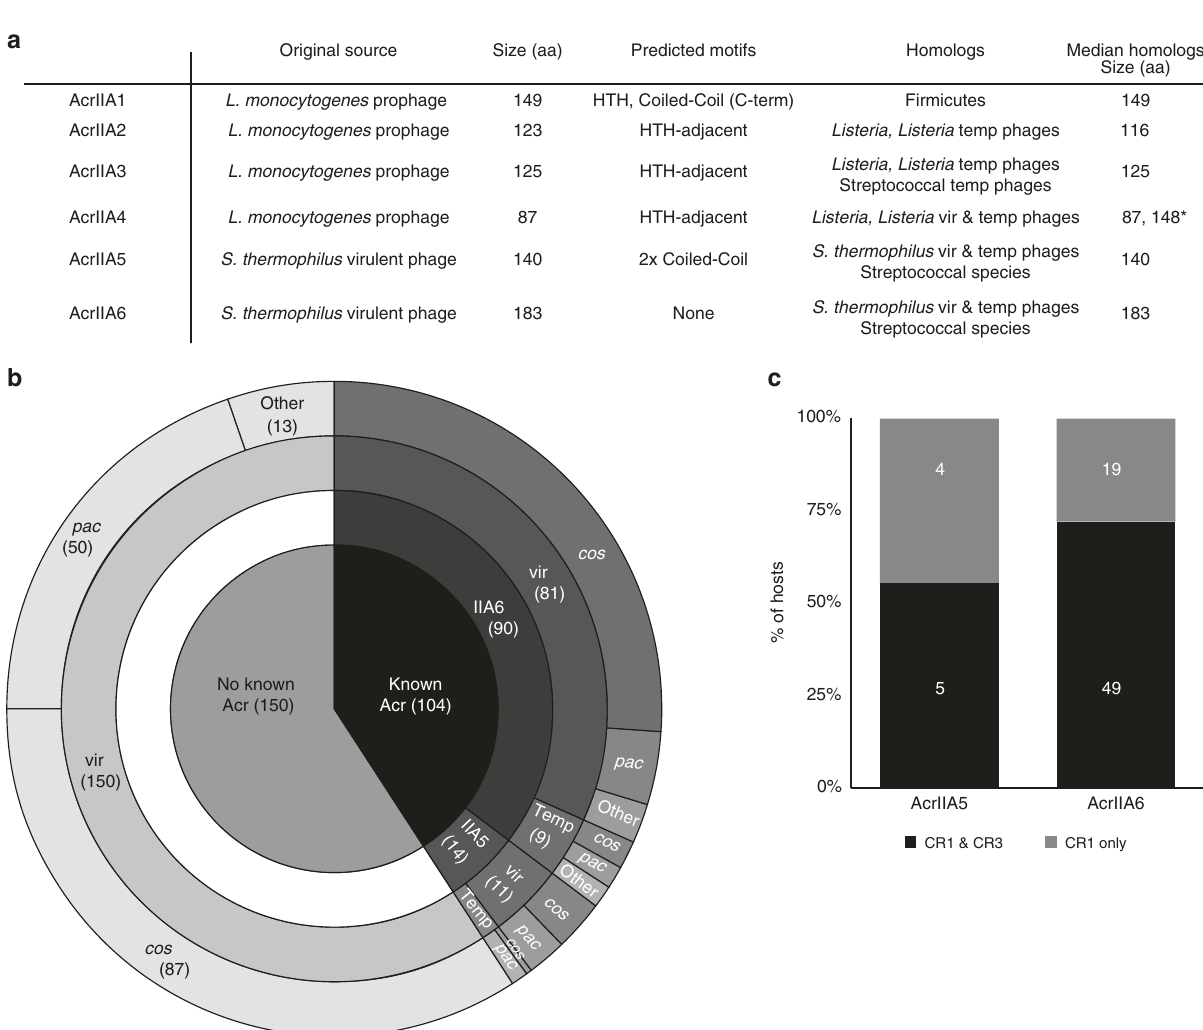
Fig. 2 Bioinformatic analyses of type II-A Acrs. a A summary of key features of type II-A Acrs. For orthologs, virulent and temperate are abbreviated “ vir ” and “ temp, ” respectively. The star (*) indicates a bi-modal distribution in size, with a smaller set clustering around 87 aa and a larger set (present in virulent phages) clustering around 148 aa. b Categorizing 254 available S. thermophilus phage genomes for presence of a known Acr, by Acr family, phage type (vir = virulent, temp = temperate), and group ( cos , pac , other). c A breakdown of AcrIIA5-containing and AcrIIA6-containing phages by CRISPR-Cas systems present in the host, where the host ’ s CRISPR types are known. The number of hosts for each category is presented in white over the bar graphs, and no host possesses only the CR3